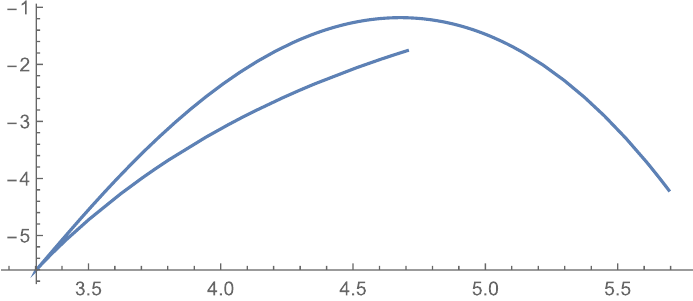
tr φ i given by (6.22) (without the overall constant C ) as a Figure 6 . Plot of singular part of h 1 N function of normalized coupling, J = ∆ /µ for fixed µ = 0 . 1 . At J ' 3 . 30259 we see the c = 0 singularity h 1 tr φ i ∼ ( g ( c =0) ) 3 / 2 . The c = − 2 singularity h 1 tr φ i ∼ ( g ( c = − 2) c − g c N N occurs at µ → 0 at fixed g , on the 1st sheet of the function (upper branch in the picture). The exponential singularity is on the 2nd sheet (w.r.t. the c = 0 branchpoint, lower branch on the